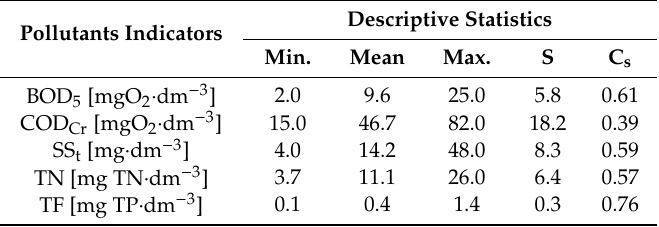
Table 1. The values of the descriptive statistics for pollutants indicators observational